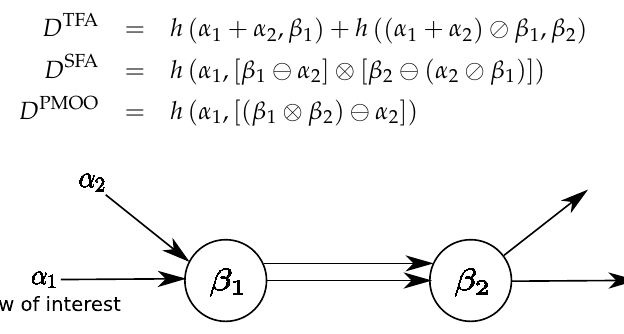
Figure 3. Simple example to illustrate bounding